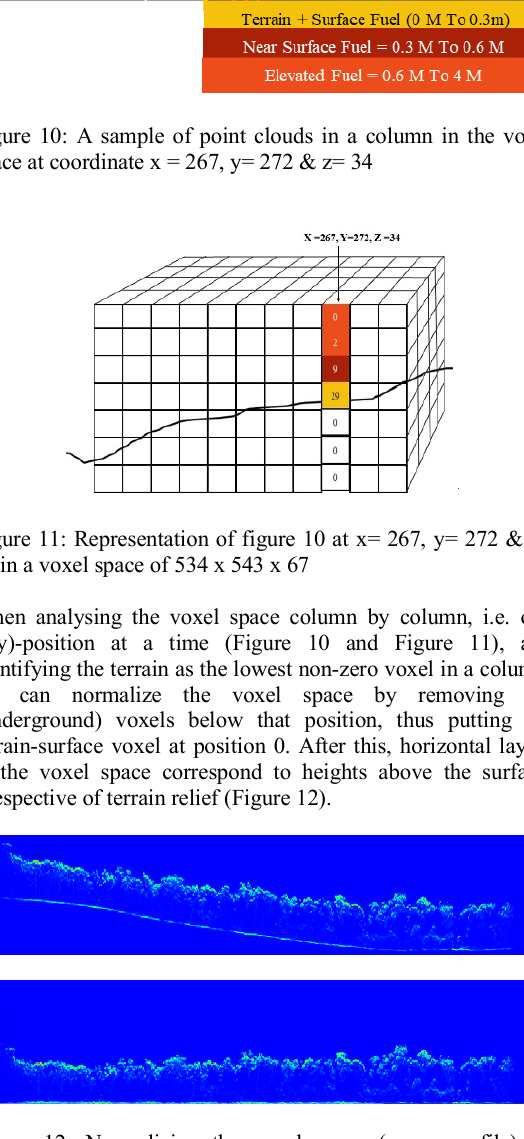
Figure 12: Normalizing the voxel space (upper profile) by shifting the terrain to the bottom of the space, i.e. flattering the terrain (lower profile).